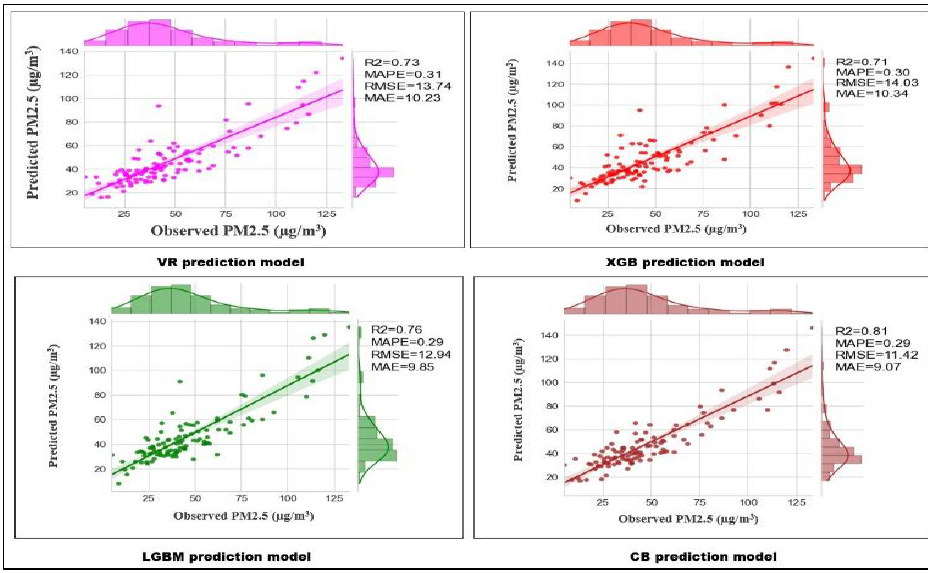
Figure 4. Regression plots of test dataset using VR, XGB, LGBM and CB prediction models.